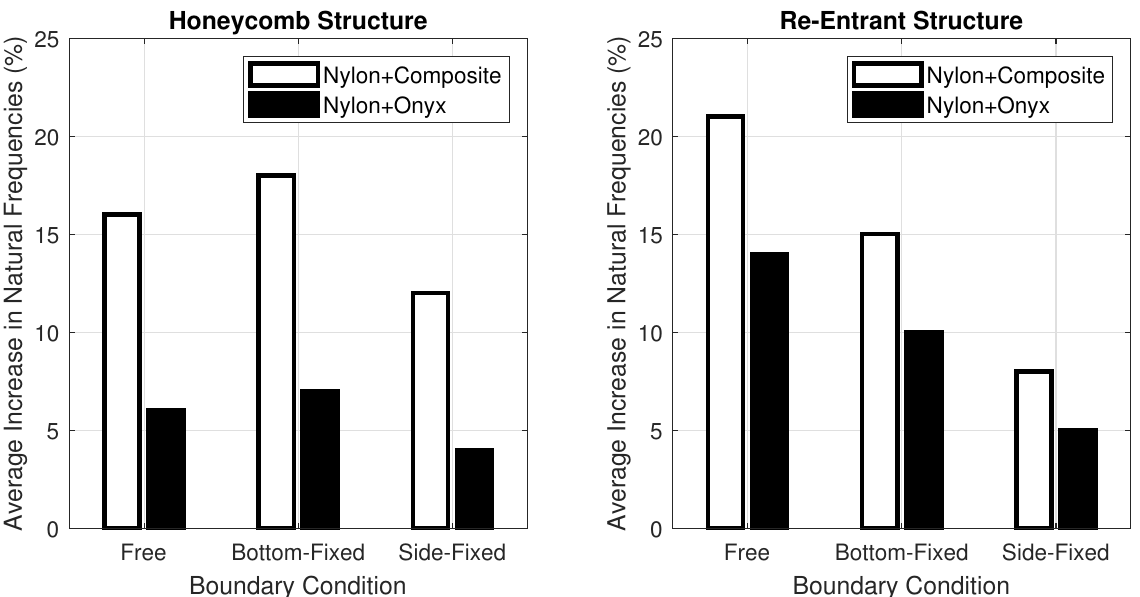
Figure 13. Average change in top five natural frequencies for honeycomb lattice structure and re-entrant lattice